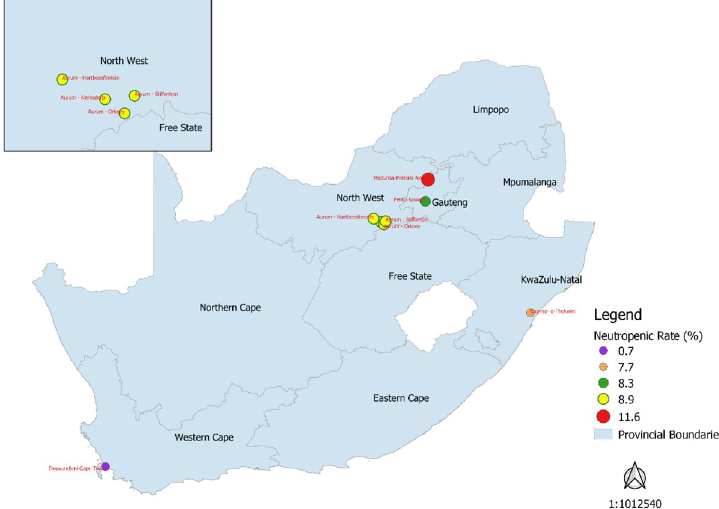
Fig 2. Prevalence rates of BEN in each HVTN 503 clinical research site and its representative area. Medunsa- Pretoria (red circle), PHRU-Soweto (green circle), Aurum-KOSH (yellow circles), d) Caprisa-eThekwini (orange circle), Emavundleni-Cape Town (purple